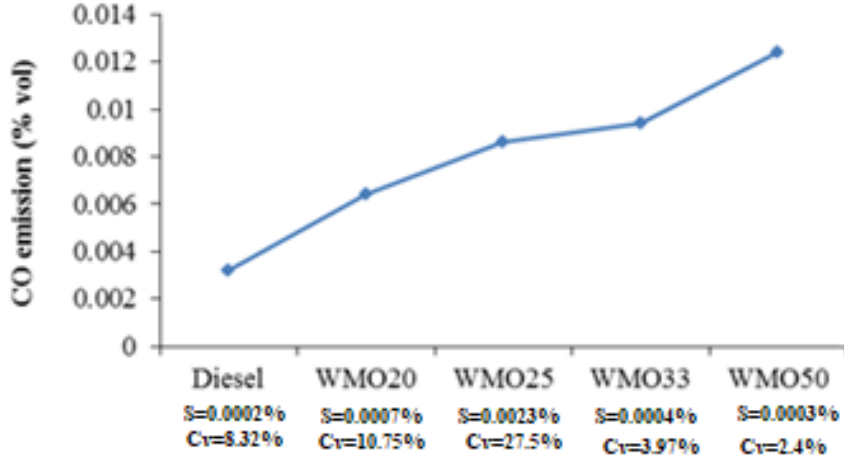
Figure 3. CO variations for different fuels.